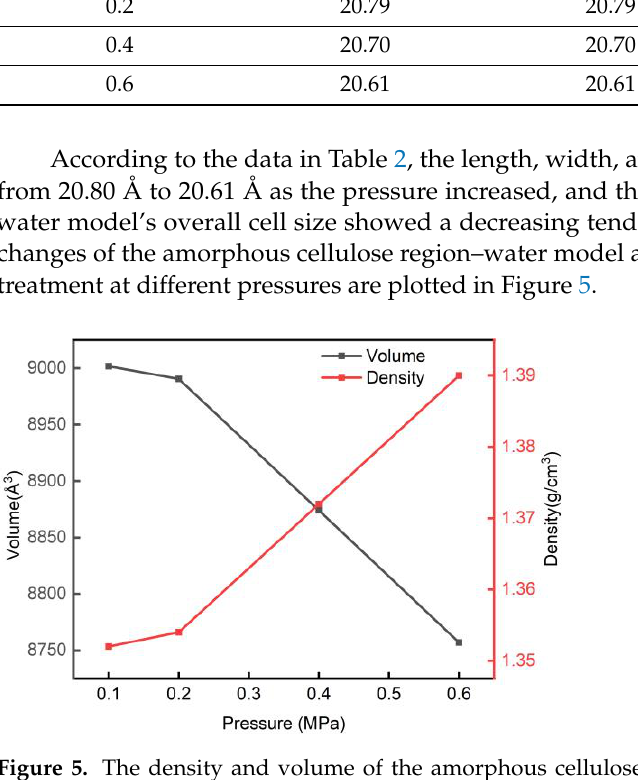
Figure 5. The d ensity and volume of the amorphous cellulose region – water model at different pres- Figure 5. The density and volume of the amorphous cellulose region–water model at different sures; 1 nm = 10 Å . pressures; 1 nm = 10